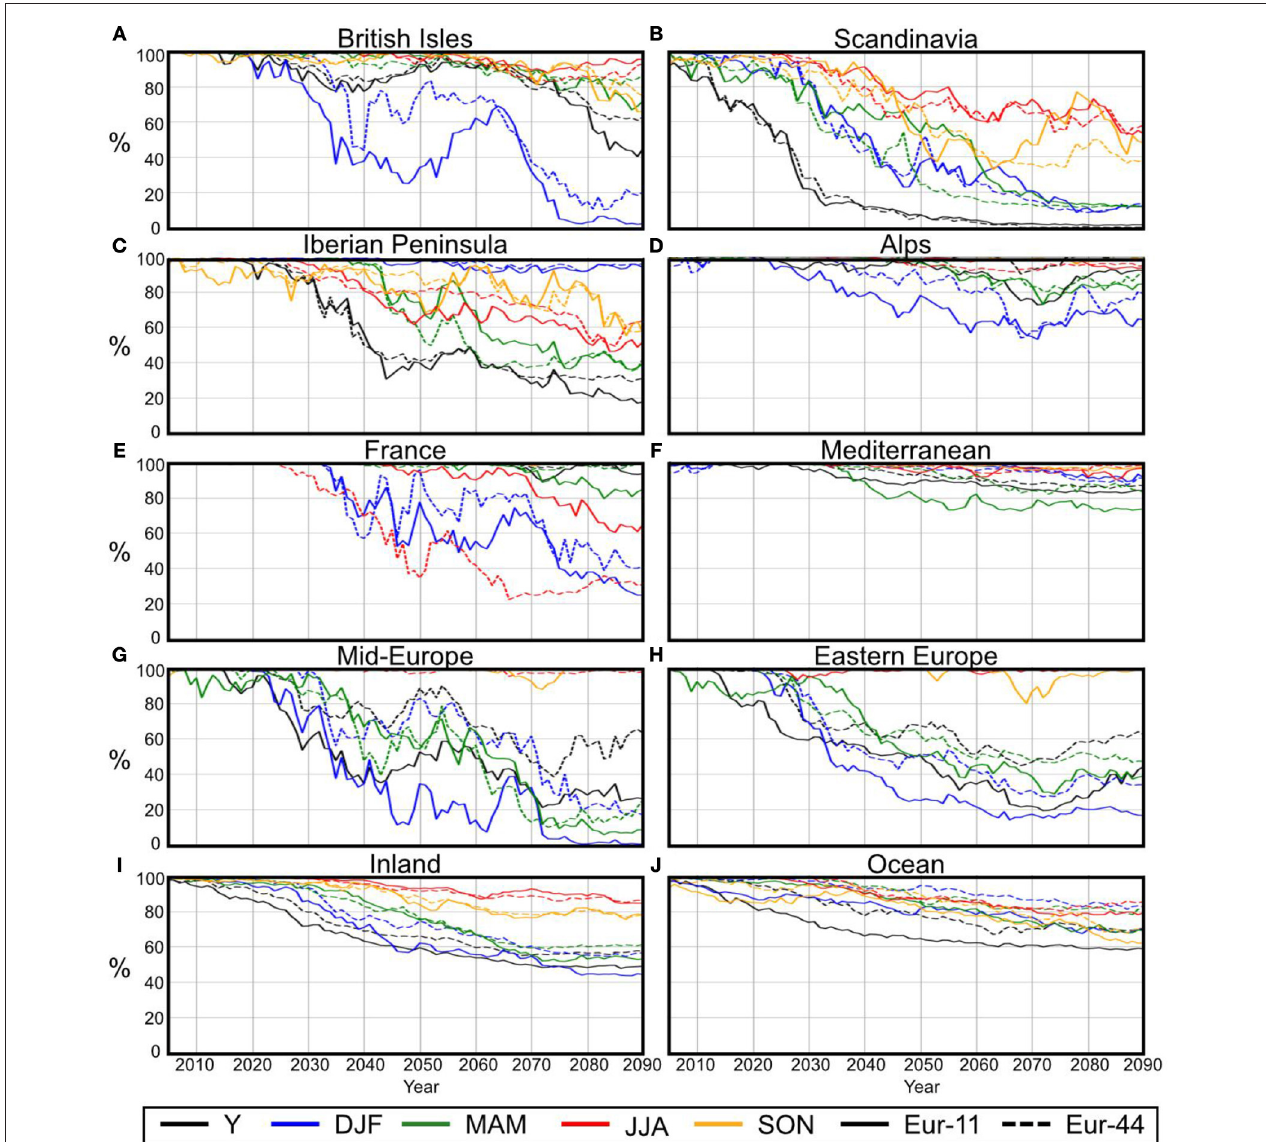
FIGURE 6 | Percentage of inland grid points where S/N < 1 for absolute precipitation for each subdomain (A–H) and for land (I) and ocean (J) grid points in the full